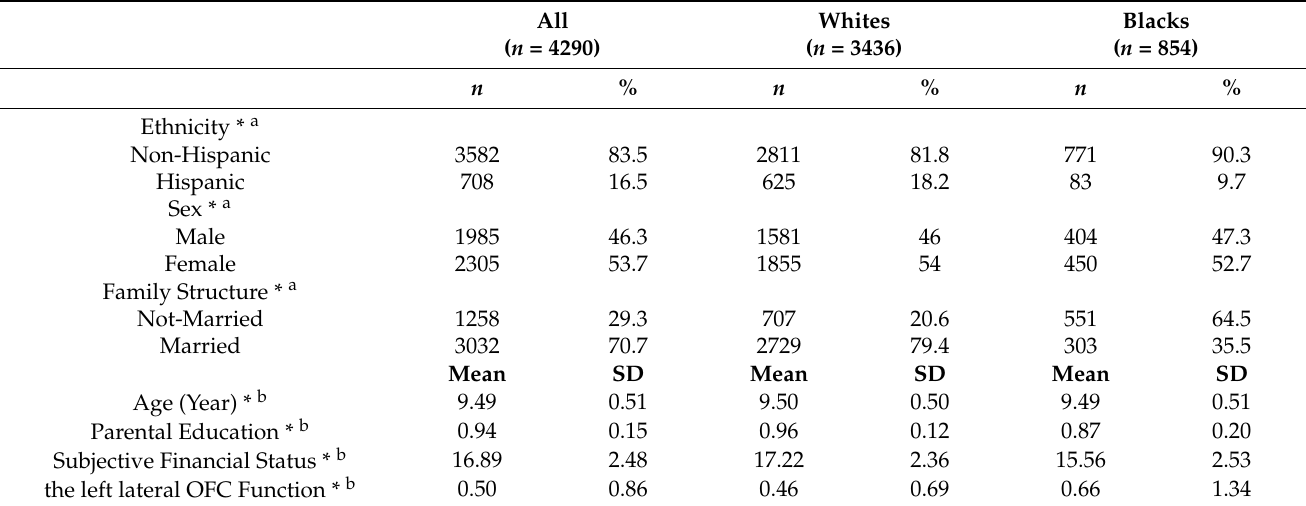
Table 1. Descriptive data overall and by race ( n = 4290).